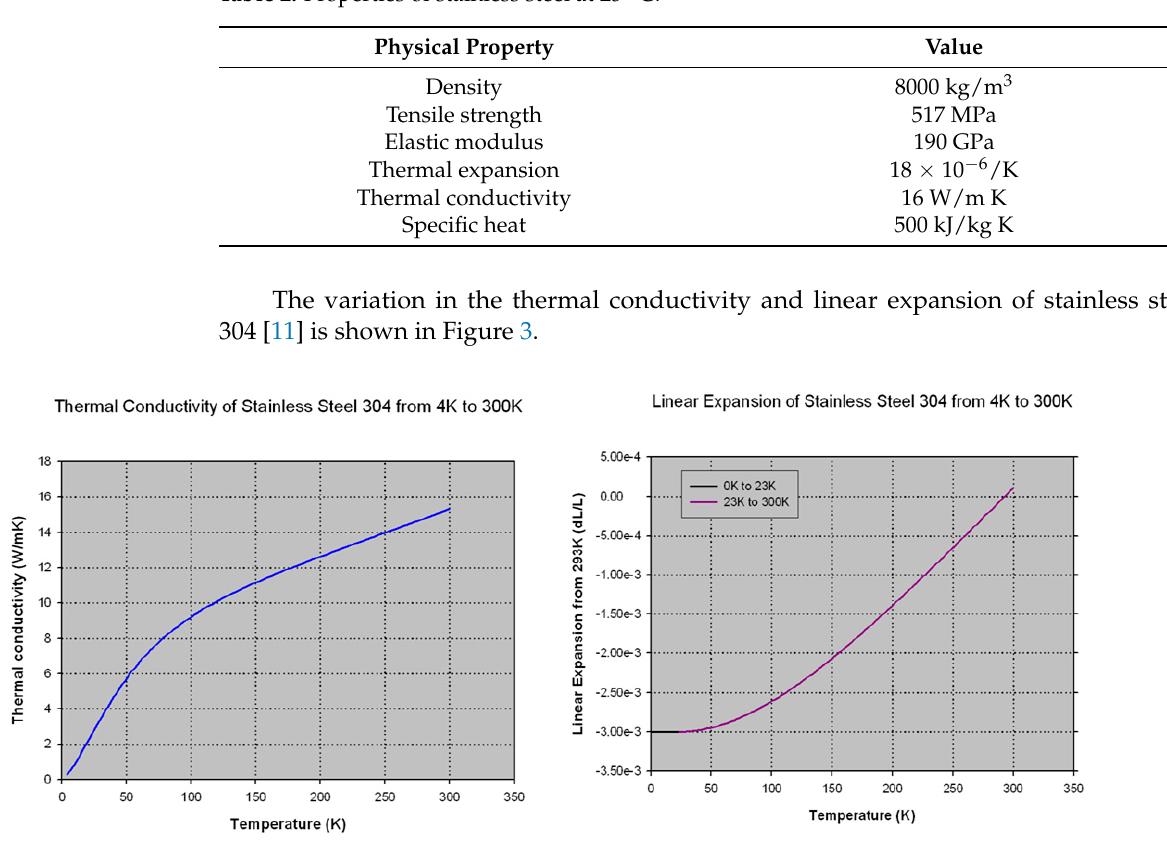
Figure 2. Variation in the thermal conductivity and linear expansion of aluminum 5083 [11].